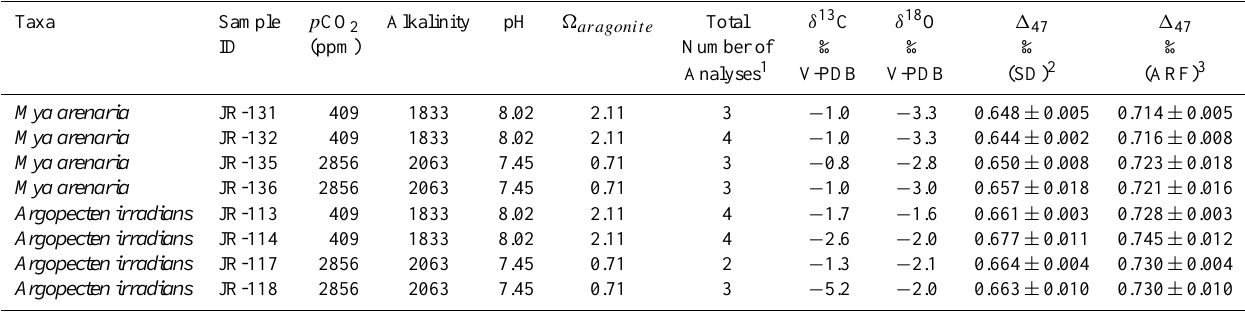
Table 6. Stable isotope data for individual cultured mollusk specimens grown at ambient carbonate saturation state and undersaturated